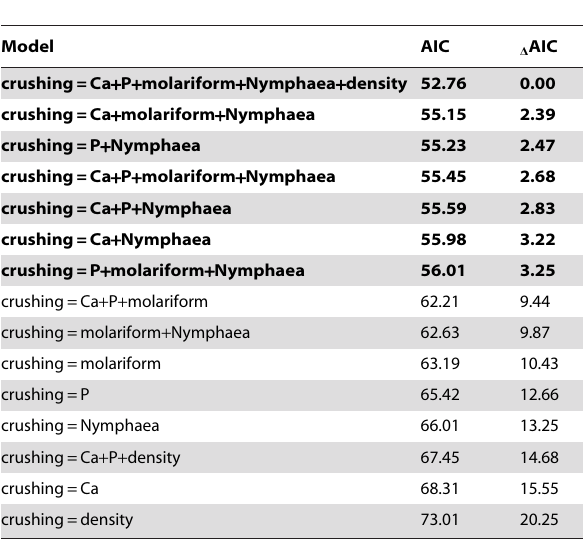
Table 1. Competing linear regression models ranked by AIC